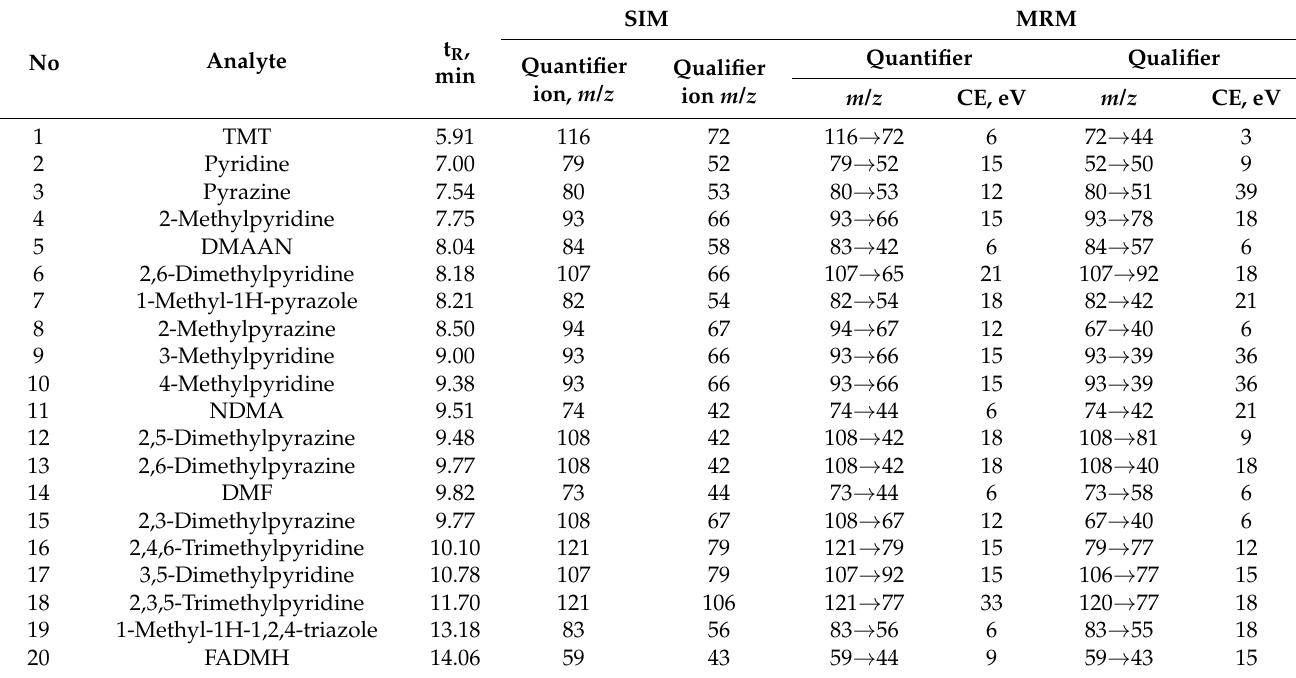
Table 4. GC-MS parameters for SIM and MRM detection